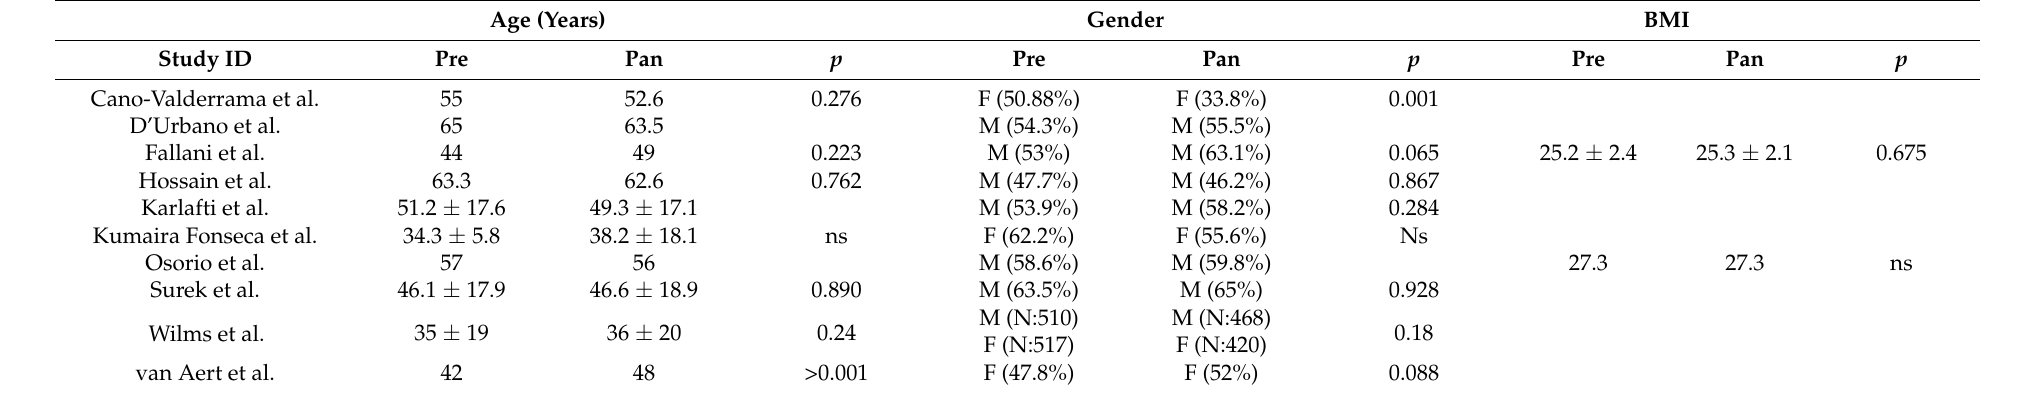
Table A2. Summary findings with characteristics of patients of the included studies.